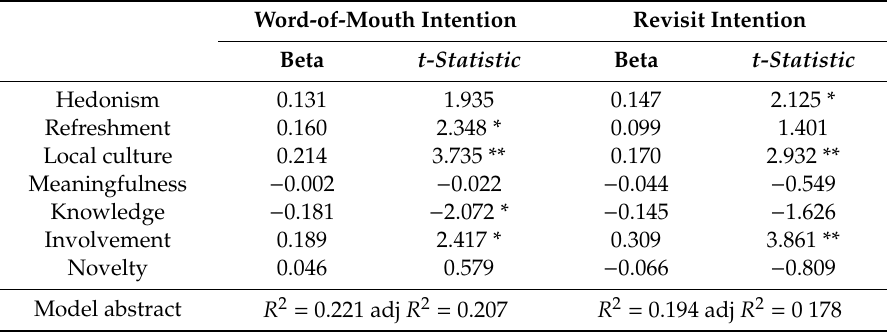
Table 3. Influences of memorable tourism experiences on word-of-mouth intention and revisit intention.